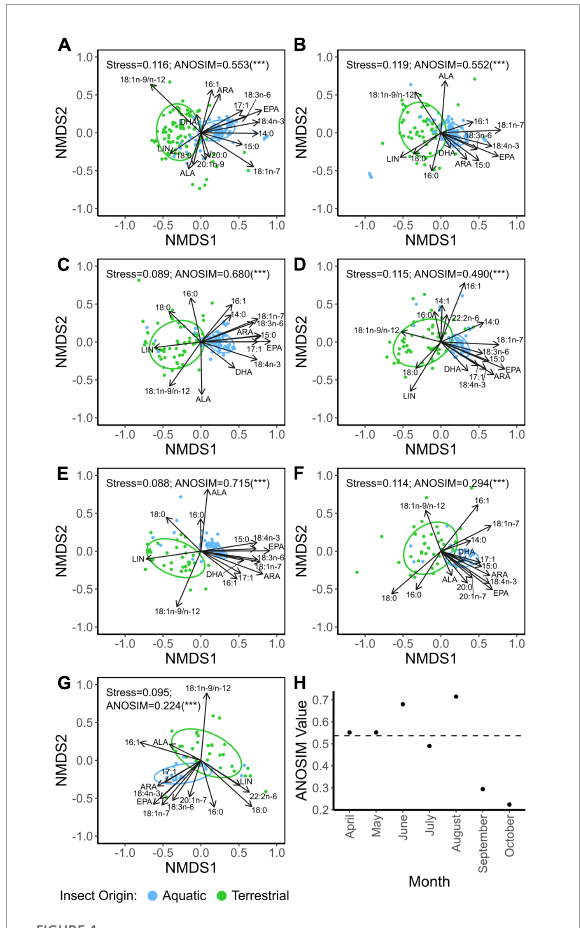
FIGURE4 Non-metric multidimensional scaling (NMDS) of arcsine-square-root-transformed fatty acid fractions (% of total fatty acids) of aquatic and terrestrial insects of April (A) , May (B) , June (C) , July (D) , August (E) , September (F) , and October (G) . Asterisk represent significant ANOSIM (Analysis of Similarities) comparisons; “***” represent p < 0.0001. (H) ANOSIM value representing the similarity between aquatic and terrestrial insects (i.e., higher value means greater separation between groups) for each sampling month. Dashed line represents the ANOSIM value for the entire dataset. Fatty abbreviations: linoleic acid (LIN; 18:2n-6), α -linolenic acid (ALA; 18:3n-3), arachidonic acid (ARA; 20:4n-6), eicosapentaenoic acid (EPA; 20:5n-3), and docosahexaenoic acid (DHA;